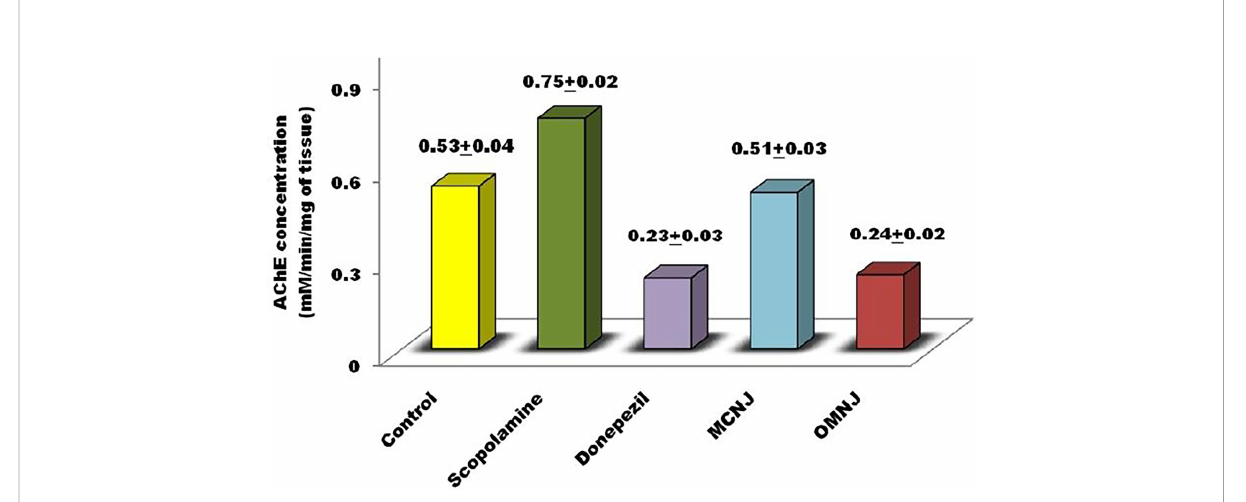
FIGURE 11 AChE inhibitory activity exerted by various extracts and standard drugs in different groups.